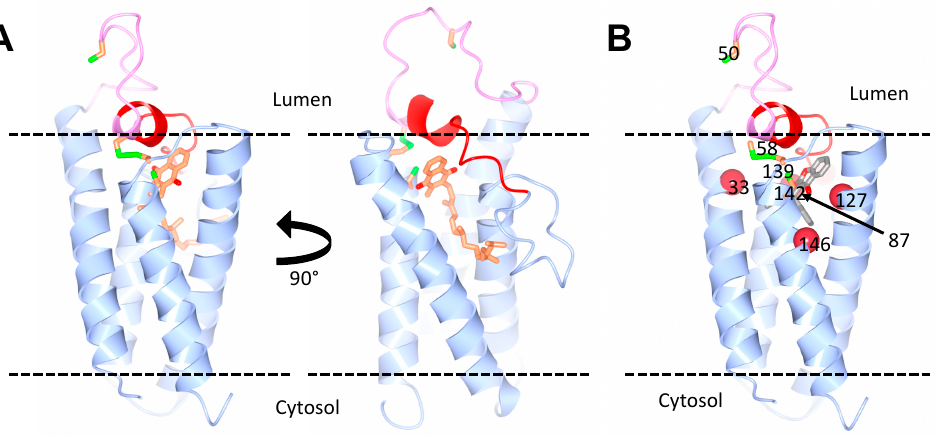
Figure 2. Predicted structure of human VKORC1L1. ( A ) Homology models of VKORC1L1, bound to vitamin K, based on the structure of the bacterial VKOR homologue. The vitamin K molecule is shown in orange. Two views of the model are shown with a 90° horizontal rotation. ( B ) Model of VKORC1L1 bound to warfarin. The warfarin ‐ binding pocket (grey) is surrounded by residues (red spheres) that, when mutated, cause a strong resistance in both VKOR1L1 and VKORC1 (Ala33, Asn87, Leu127 and Y146 in VKORC1L1). The cap domain (red) and the luminal loop (pink) are also highlighted. The conserved cysteines (green and orange) are shown: Cys58 and Cys139 as disulfide, and Cys50 and Cys142 as free. Courtesy of Dr. Weikai Li, Washington University in St.